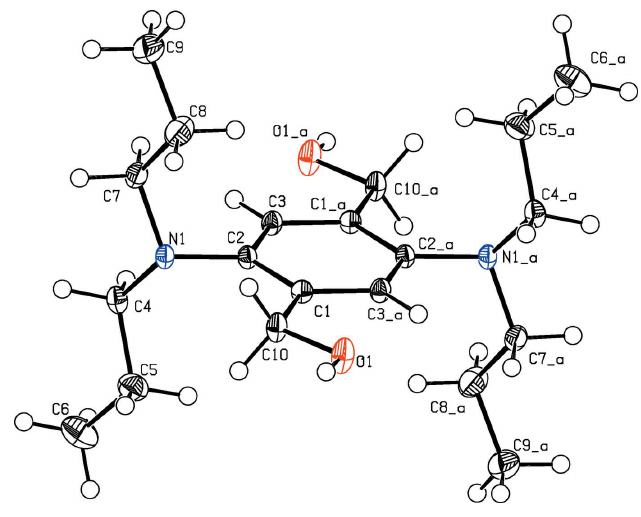
Figure 1 The molecular structure with displacement ellipsoids drawn at the 50% probability level. Symmetry code: (a) 1 (cid:4) x , 1 (cid:4) y , (cid:4) z .